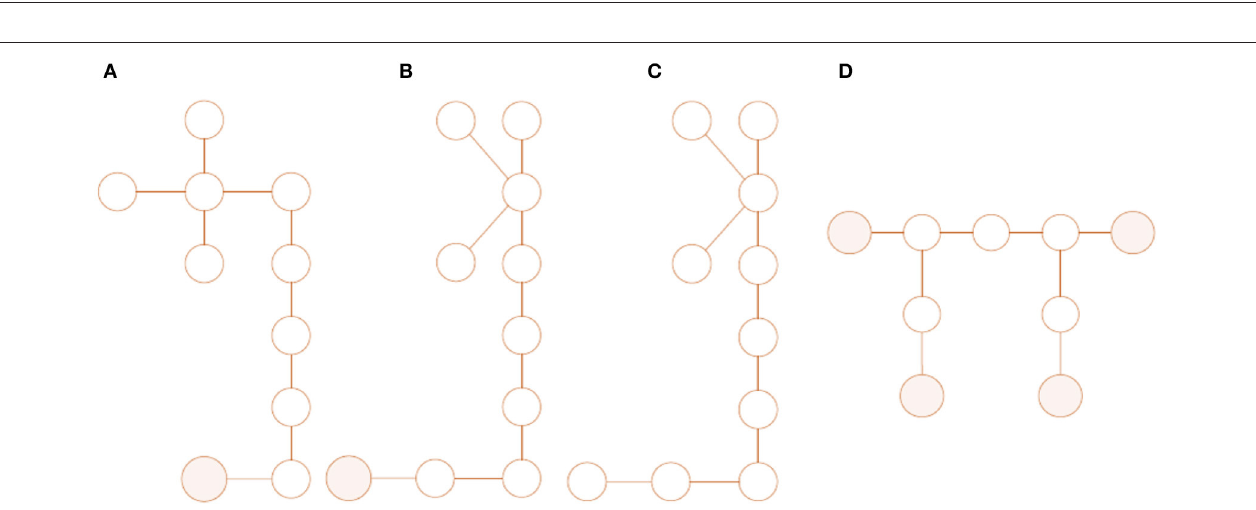
FIGURE 9 | Graphical representations of structures, ground nodes are shaded. (A,B) : Two topologically-equivalent graphs, used to represent structurally-equivalent wind turbines, that have simply been drawn differently. (C) : A graph that is topologically equivalent to (A,B) but not structurally, due to inconsistency in ground nodes. (D) a graph used to represent a three-span bridge, that is topologically and structurally inequivalent to (A–C) .